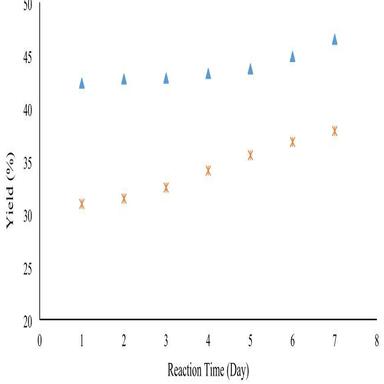
Yield of E3 experiments estimated by GPC analysis for conjugation conducted using Process B (orange x) and Process C (blue triangle) for a 1:1 wt. ratio of 40 kDa dextran and BSA lyophilized at pH 7.8.